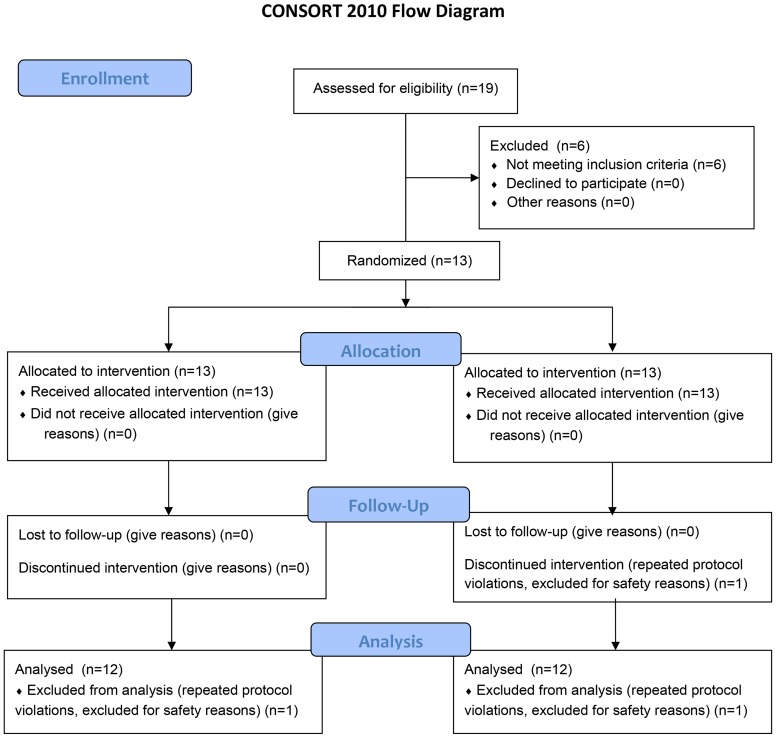
Consort Flow Diagram.